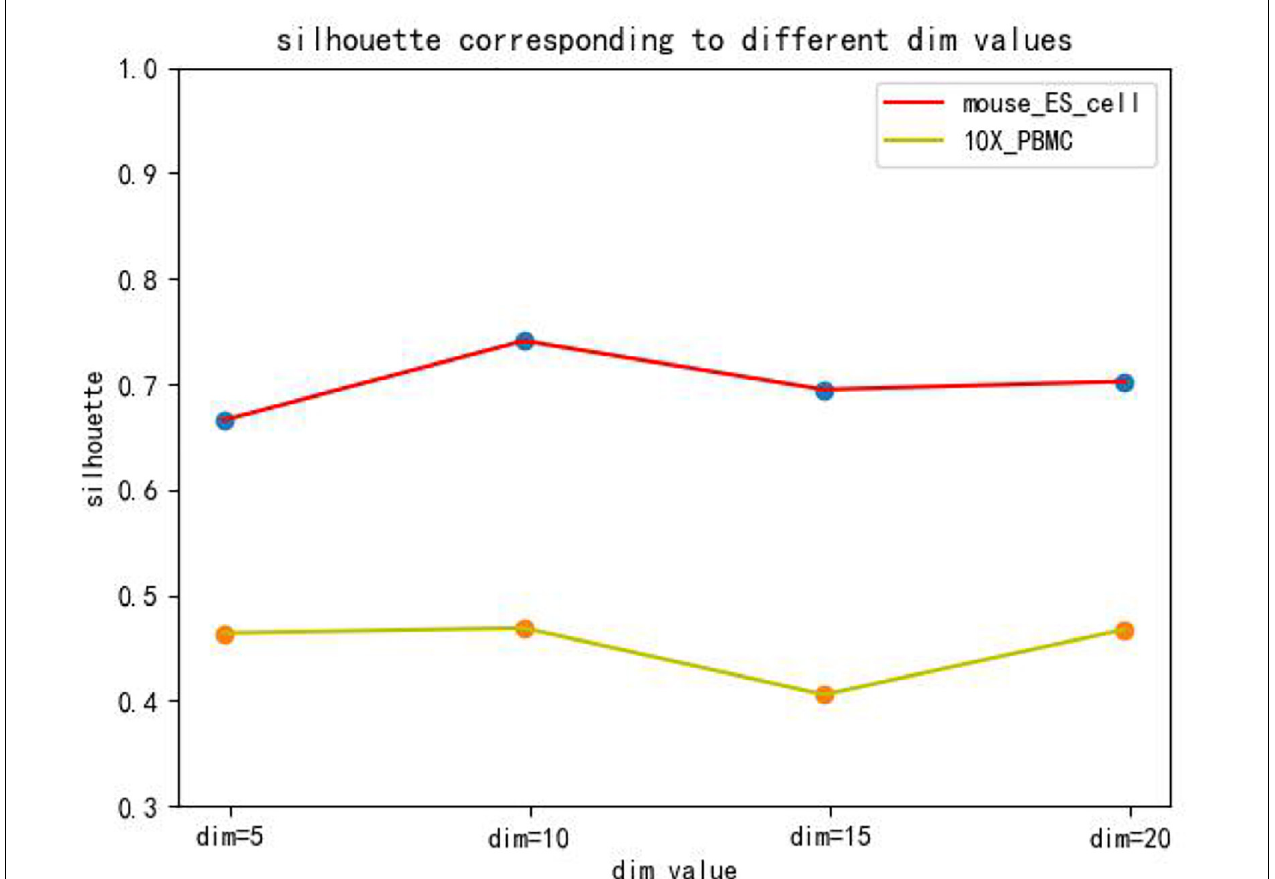
FIGURE 5 | The influence of hidden layer nodes on SCDRHA under